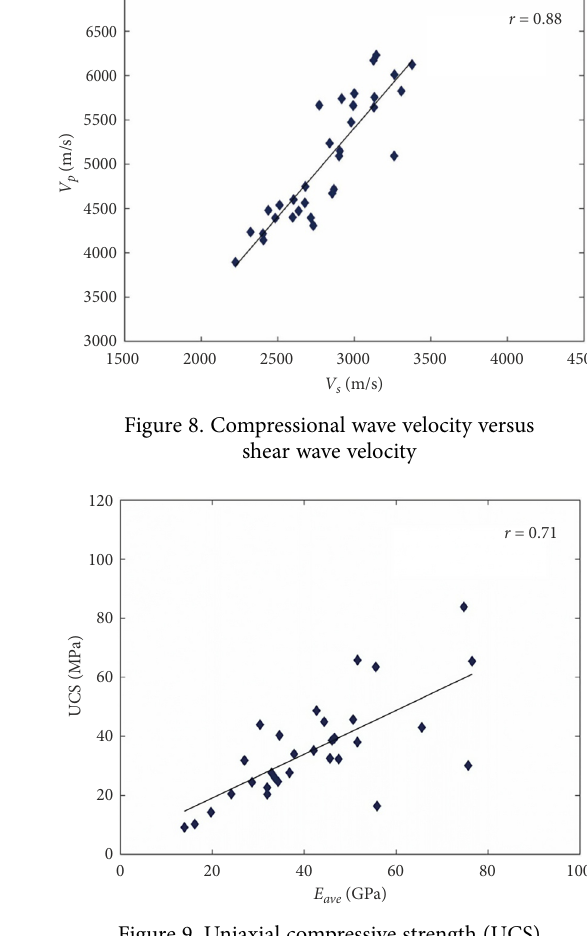
Figure 9. Uniaxial compressive strength (UCS) versus average Young’s